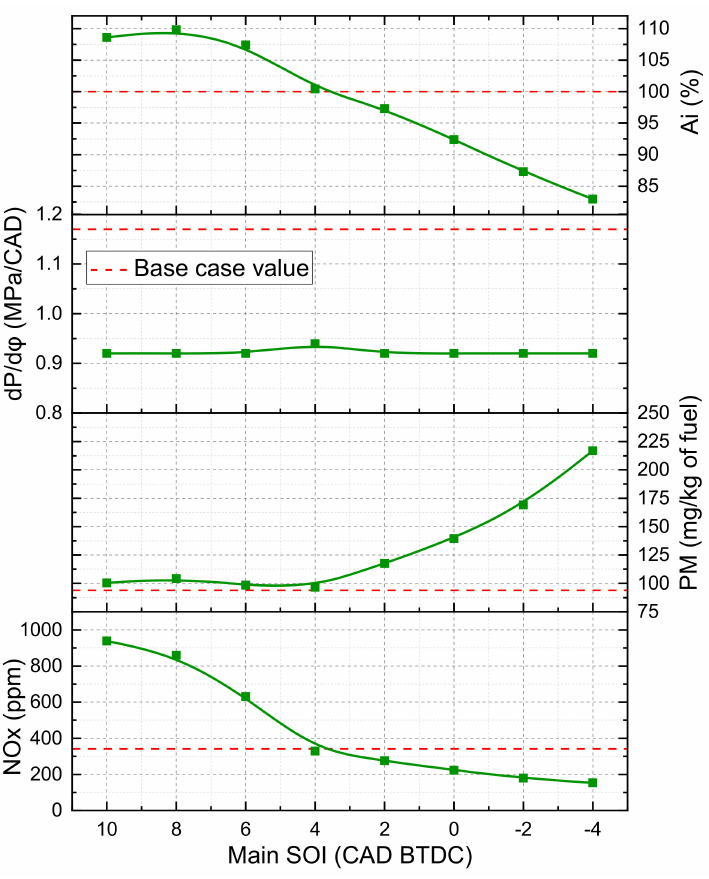
Figure 19. The main SOI variable influence on combustion process and